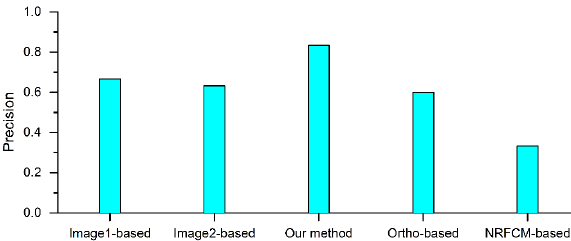
Figure 6. Retrieval accuracy of our method and the other four methods.